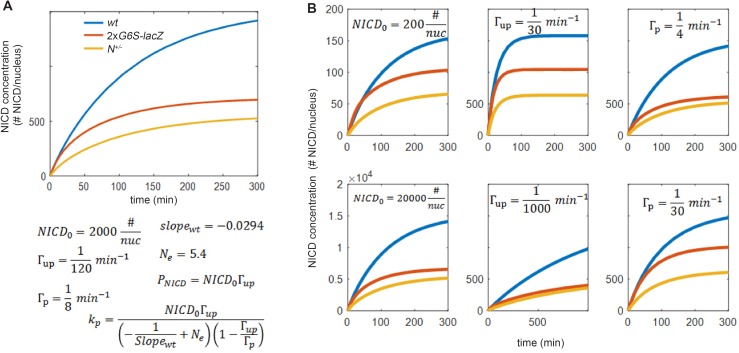
Dynamic model is robust for to variations in parameters.(A) Top: Simulation of NICD levels as a function of time after the onset of Notch activation (at t=0 min) in wild-type (blue), N heterozygotes (yellow) and SPS-GBE flies (red). Bottom: Parameters used for the model. The values of slopewt and Ne were extracted from the analysis of Figure 4H. Other parameter values were chosen in the middle of the range estimation as described in the modeling section. (B) Simulations of NICD levels as a function of time for different parameters as indicated. In each plot, one parameter is changed compared to (A) with all other parameters remaining the same. This analysis shows that varying NICD0 and Γup over two orders of magnitude, and Γp over one order of magnitude do not affect the general conclusion that long duration processes, but not short duration processes, are sensitive to the CDK8-mediated degradation mechanism.